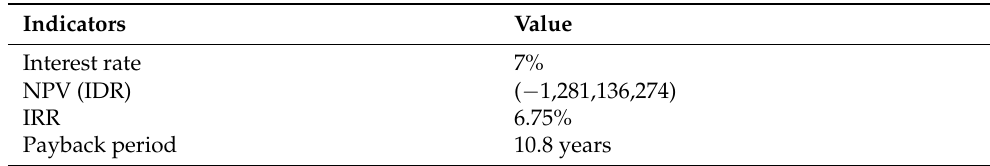
Table 6. Profitability evaluation of the biogas